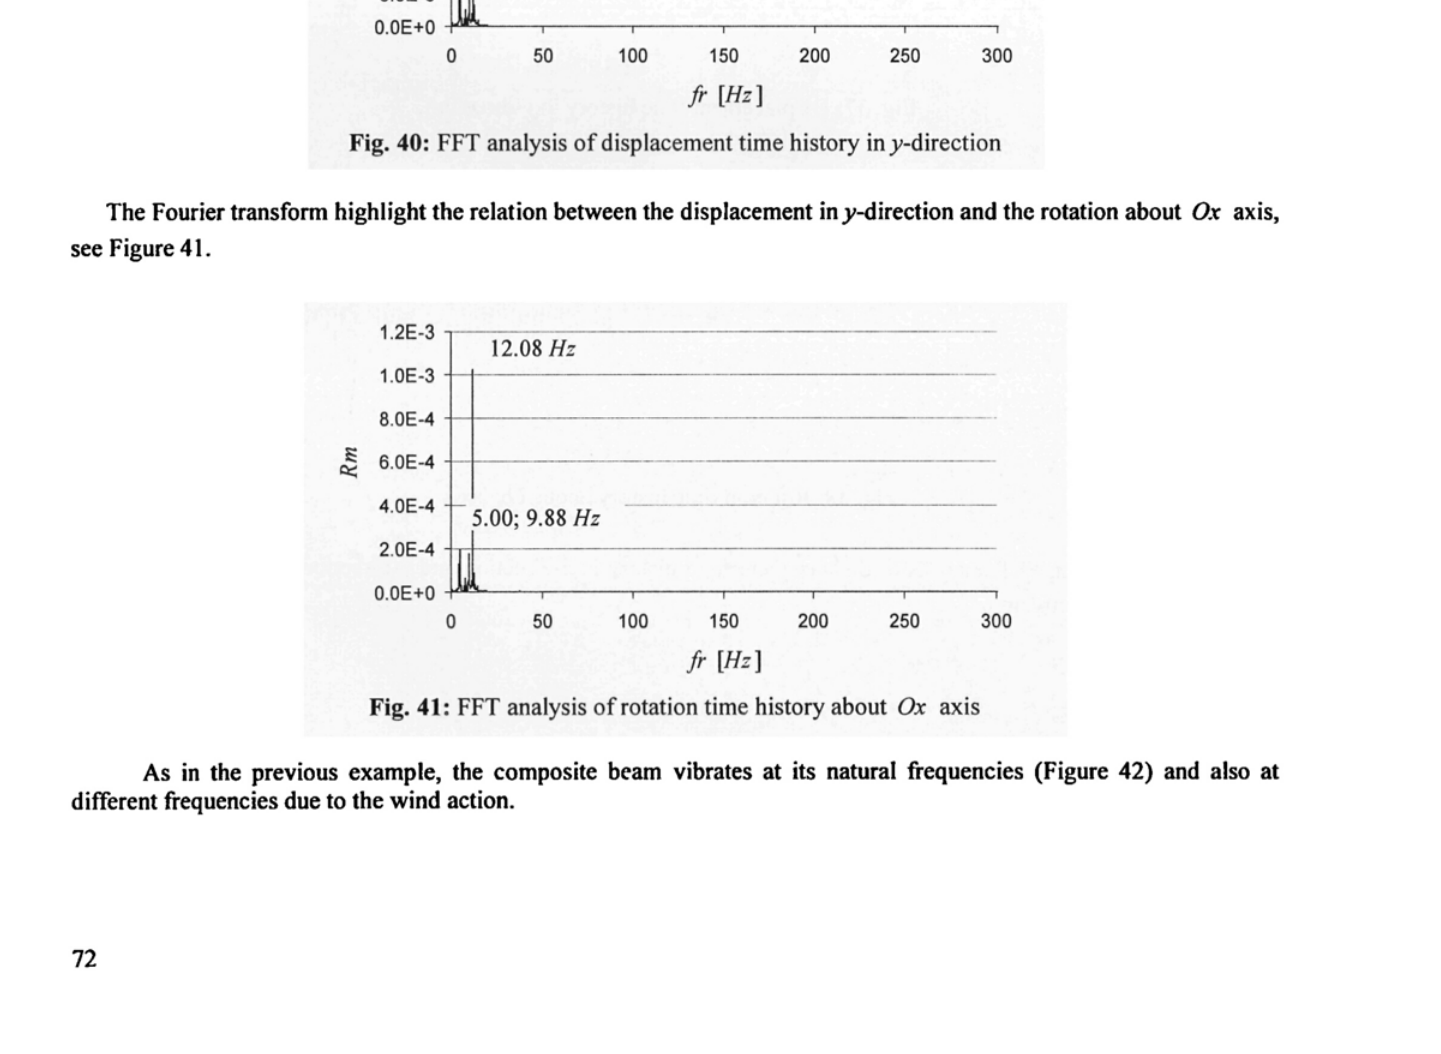
Fig. 39: FFT analysis of displacement time history in ^-direction